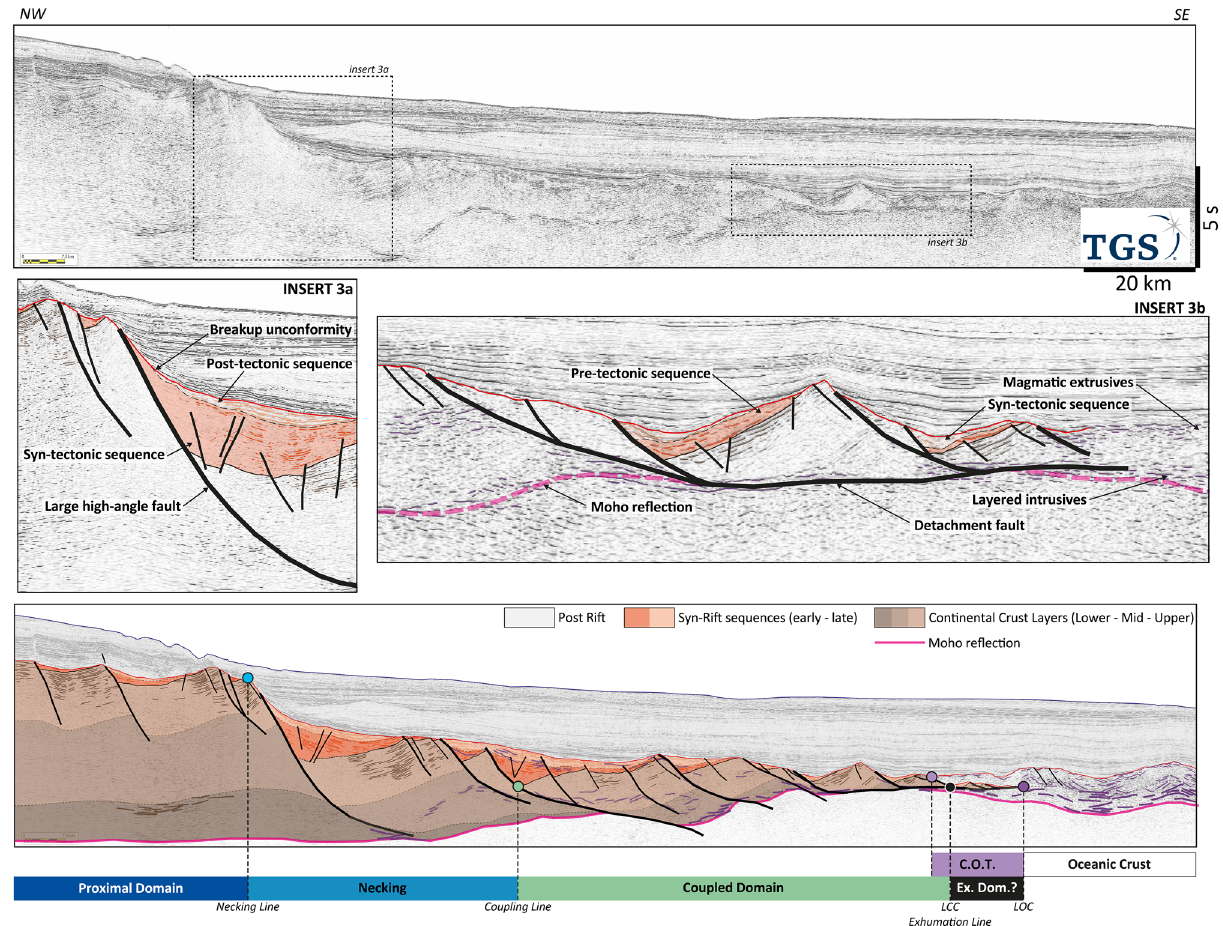
Figure 3. Somalia case study. The section is characterized by a short necking domain accommodated on a couple of high-angle normal faults. The coupled domain is longer with faults extending down to the mantle and cutting the interpreted Moho reflection in several cases. The most external domain is characterized by low- angle faults and detachments exhuming the mantle and leaving rafts of the pre-rift material on the exhumation surface. The emplacement of oceanic magmatism is progressive over this exhumed mantle. The data are courtesy of